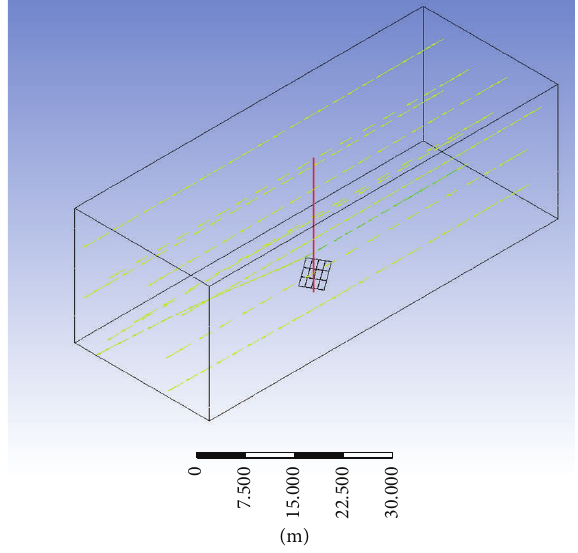
Figure 7: Profile location of the velocities plot for mesh conver-